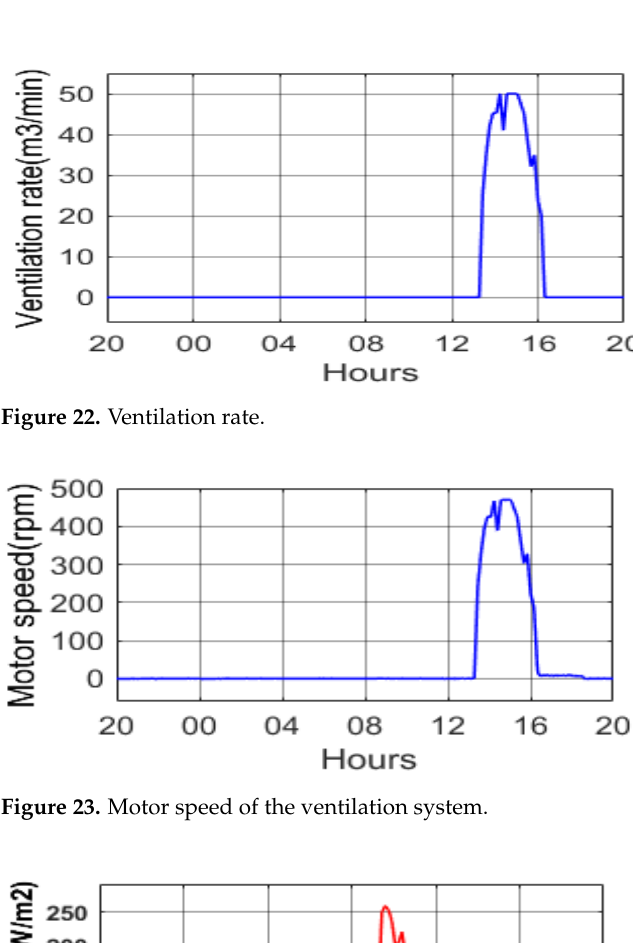
Figure 24. Heating rate of the greenhouse.